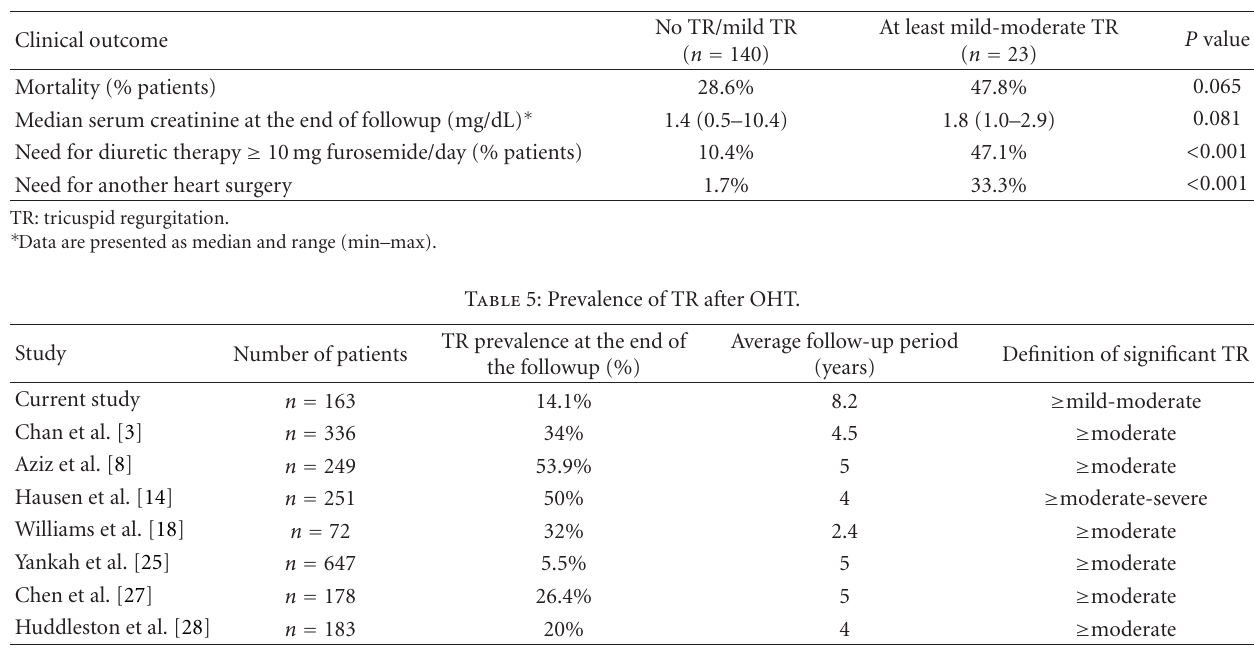
Table 4: Clinical outcomes of late significant (at least mild-moderate) TR.